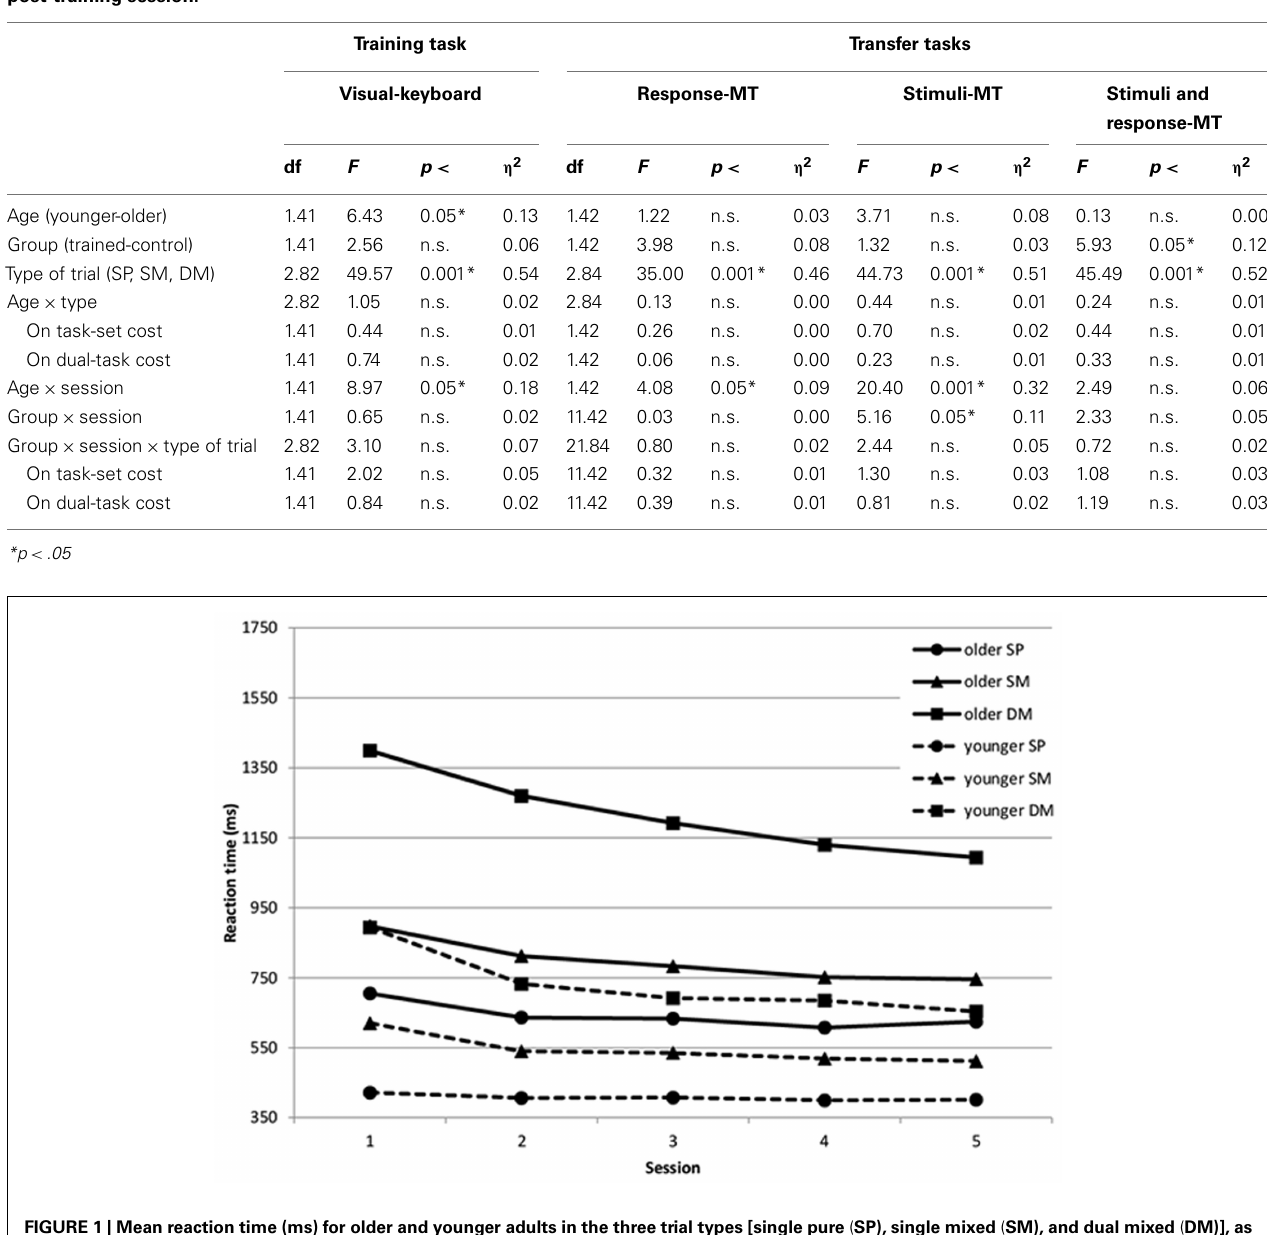
Table 3 | Results of the analyses of variance performed on accuracy for the training and transfer tasks conditions used in the pre-training and post-training session.